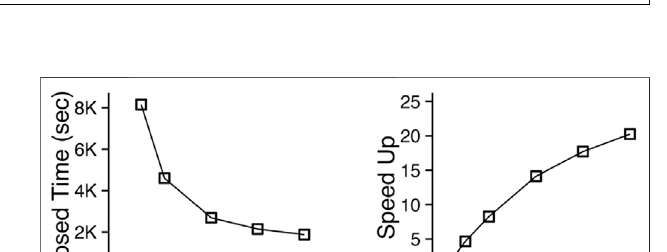
FIGURE 5 | D-CUBE scales (sub-)linearly with all input factors regardless of memory budgets.